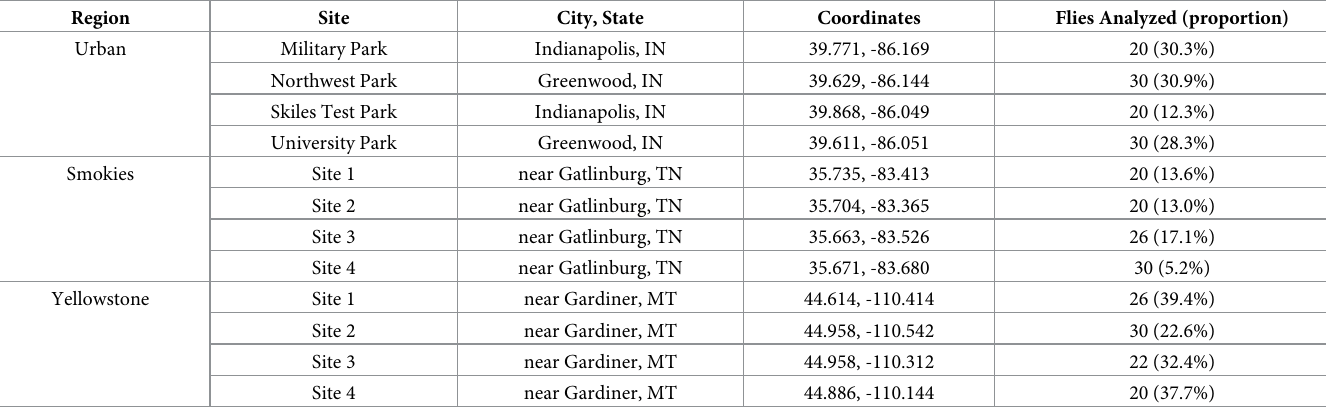
Table 4. Summary of blow fly sampling sites per region.